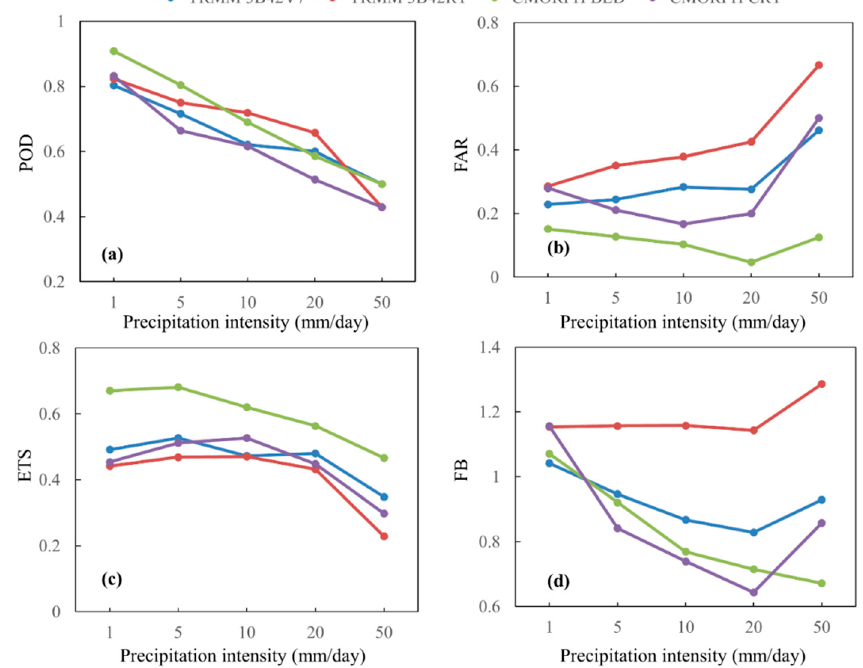
Figure 8. Metrics of ( a ) POD, ( b ) FAR, ( c ) ETS and ( d ) FB of different daily satellite products against CGDPA at the thresholds of 1 mm/day, 5 mm/day, 10 mm/day, 20 mm/day and 50 mm/day during 2006–2013.